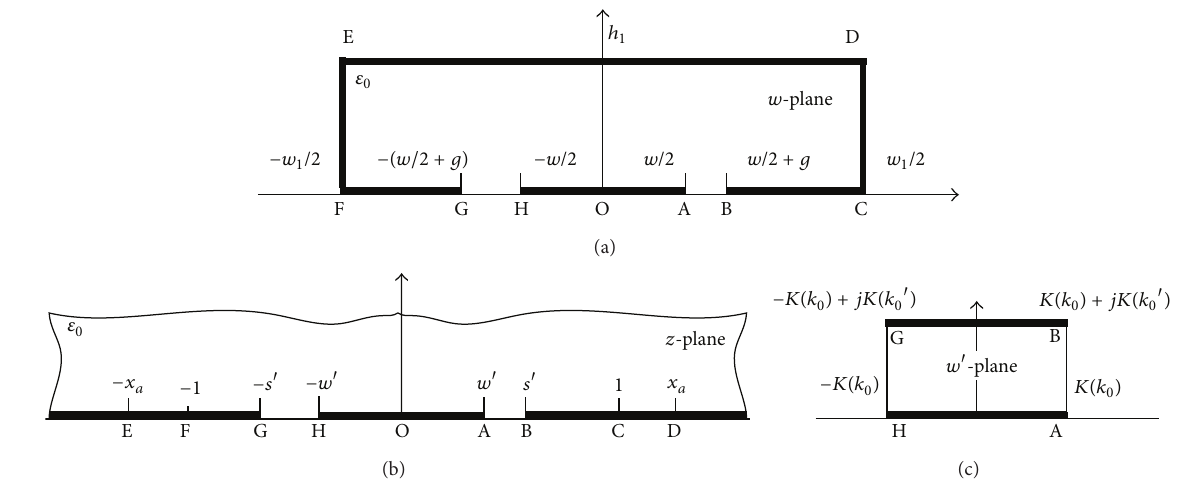
Figure 6: Conformal mapping transformation for Region I of Figure 5(b).